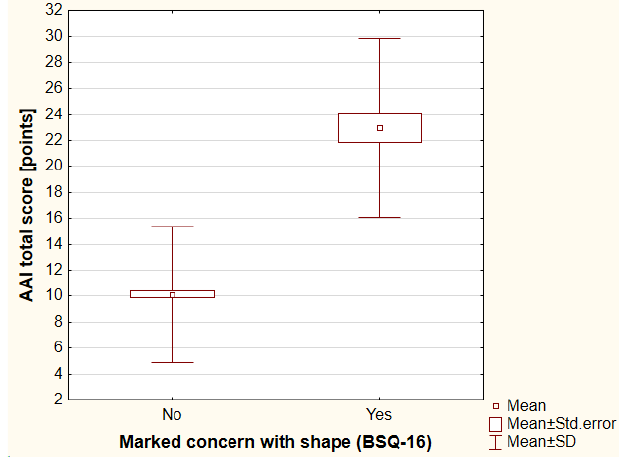
Figure 2. The differences in AAI total score between individuals with marked concern with shape and those without such concern. AAI — the Appearance Anxiety Inventory, BSQ-16 — the Body Shape Questionnaire-16, SD — standard deviation.